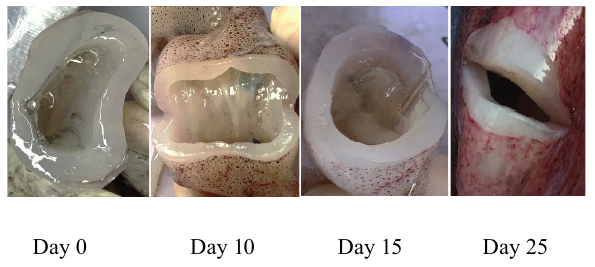
Figire 2 Changes in meat color during storage